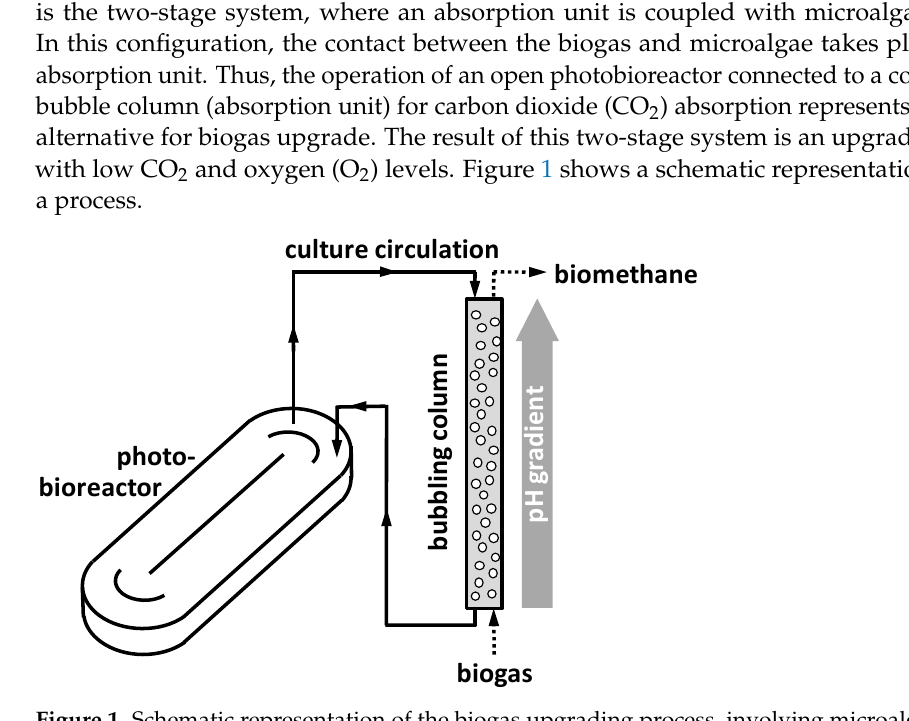
Figure 1. Schematic representation of the biogas upgrading process, involving microalgae culture and an absorption column.